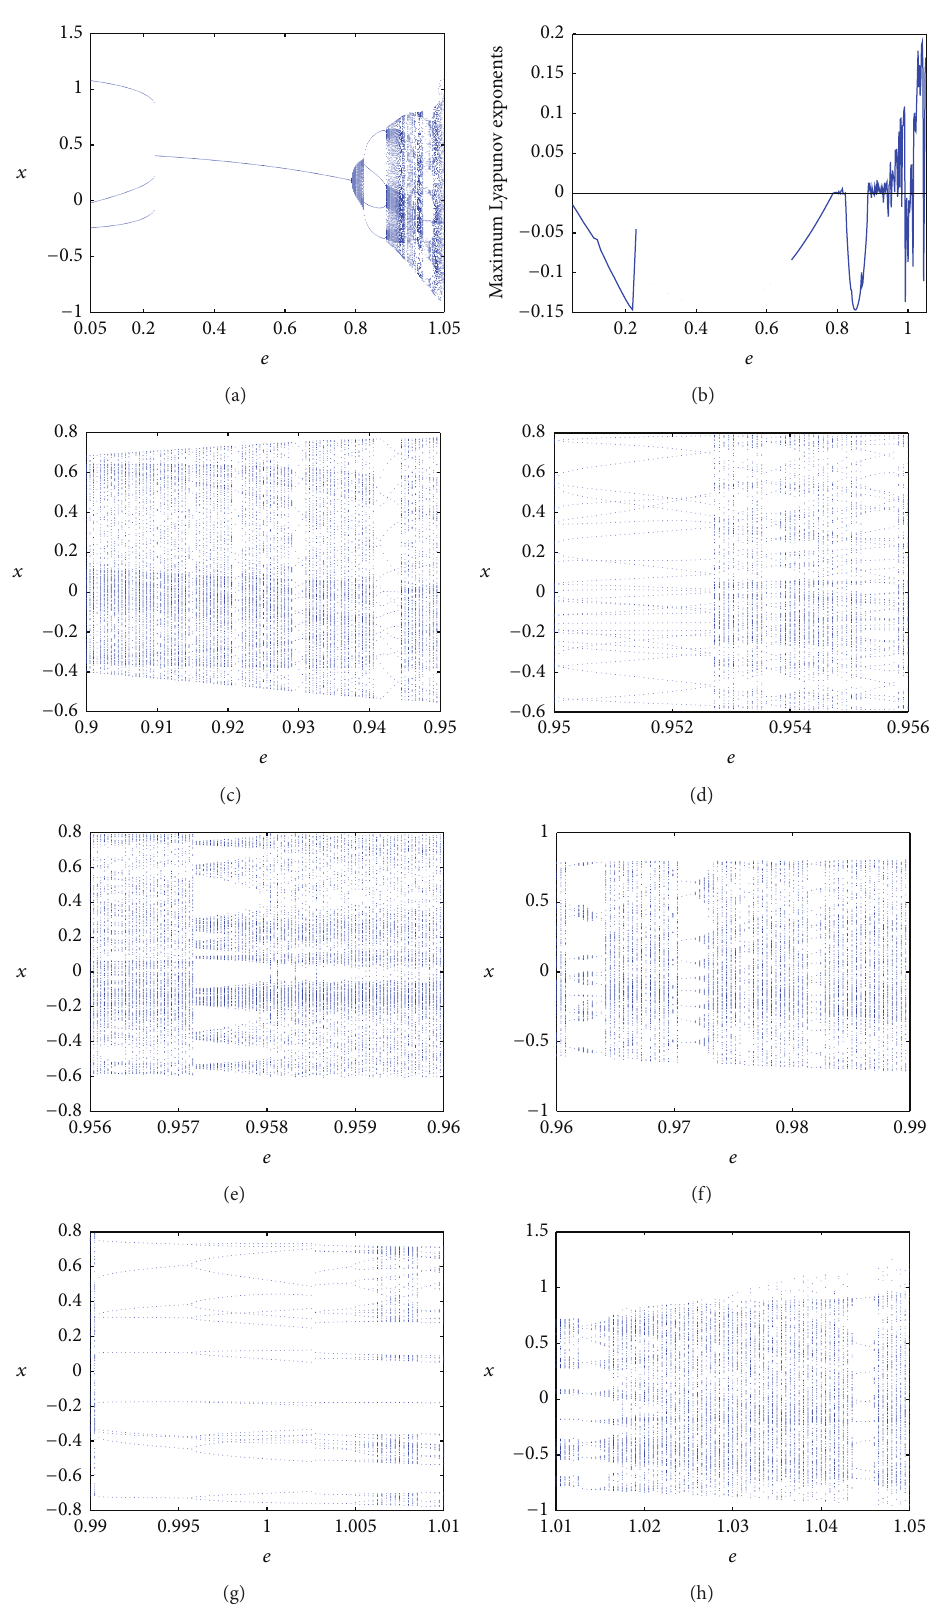
Figure 12: (a) Bifurcation diagram of map (2) in (𝑒,𝑥) plane for 𝑎 = −0.4 , 𝑏 = 1.1 , 𝑐 = −0.6 , and 𝑑 = −0.55 . (b) Maximum Lyapunov exponents corresponding to (a). (c)–(h) Local amplification of (a) for (c) 0.9 ≤ 𝑒 ≤ 0.95 , (d) 0.95 ≤ 𝑒 ≤ 0.956 , (e) 0.956 ≤ 𝑒 ≤ 0.96 , (f) 0.96 ≤ 𝑒 ≤ 0.99 , (g) 0.99 ≤ 𝑒 ≤ 1.01 , and (h) 1.01 ≤ 𝑒 ≤ 1.05